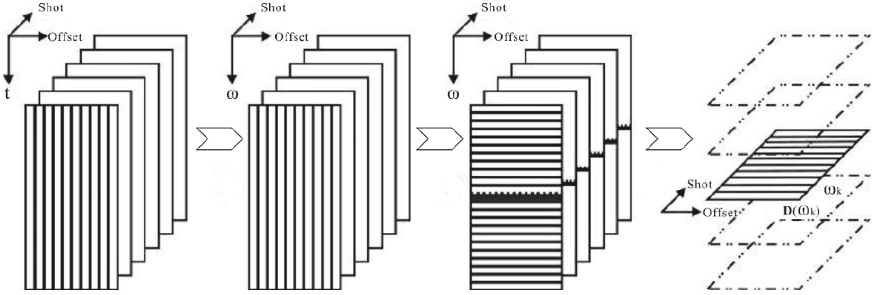
Figure 2. Demonstration of a pseudo-3D data cube.